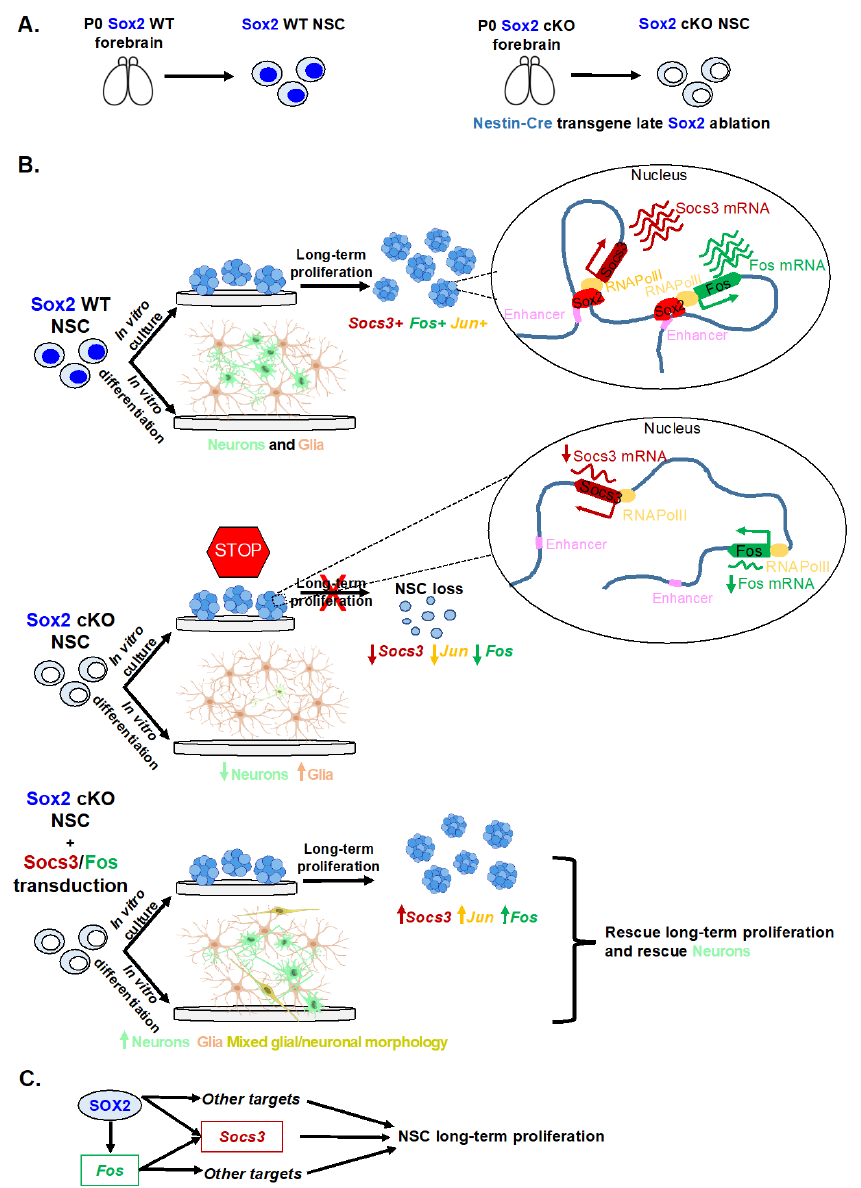
Figure 3. Schematic representation of the gene regulatory network downstream of SOX2 in forebrain-derived NSC, required for NSC proliferation and neuronal differentiation. ( A ) Sox2 -deleted (Sox2 cKO) or wild-type (Sox2 WT) NSC were derived from the forebrain (at P0) of Sox2-Nestin-Cre cKO (“late” Sox2 ablation in Figure 1) or control siblings, respectively. ( B ) Top panel, Sox2 WT NSC proliferate in long-term culture forming neurospheres and can differentiate into both neurons (green) and glia (brown). SOX2 binds to an enhancer and the promoter of both Socs3 and Fos and activates their transcription. In turn, SOX2 and FOS (AP1) bind together to the Socs3 promoter (and to many shared target genes genome-wide). Middle panel, NSC lacking Sox2 (Sox2 cKO NSC) are unable to proliferate long-term in culture, and their ability to differentiate into neurons is compromised. In addition, the expression of Socs3 and Fos is greatly reduced. Bottom panel, the overexpression of Socs3 or Fos , via viral transduction, in Sox2 cKO NSC rescues both long-term proliferation in culture and differentiation into neurons. ( C ) Regulatory relations between SOX2, FOS, and SOCS3, in neural stem cell (NSC) long-term self-renewal